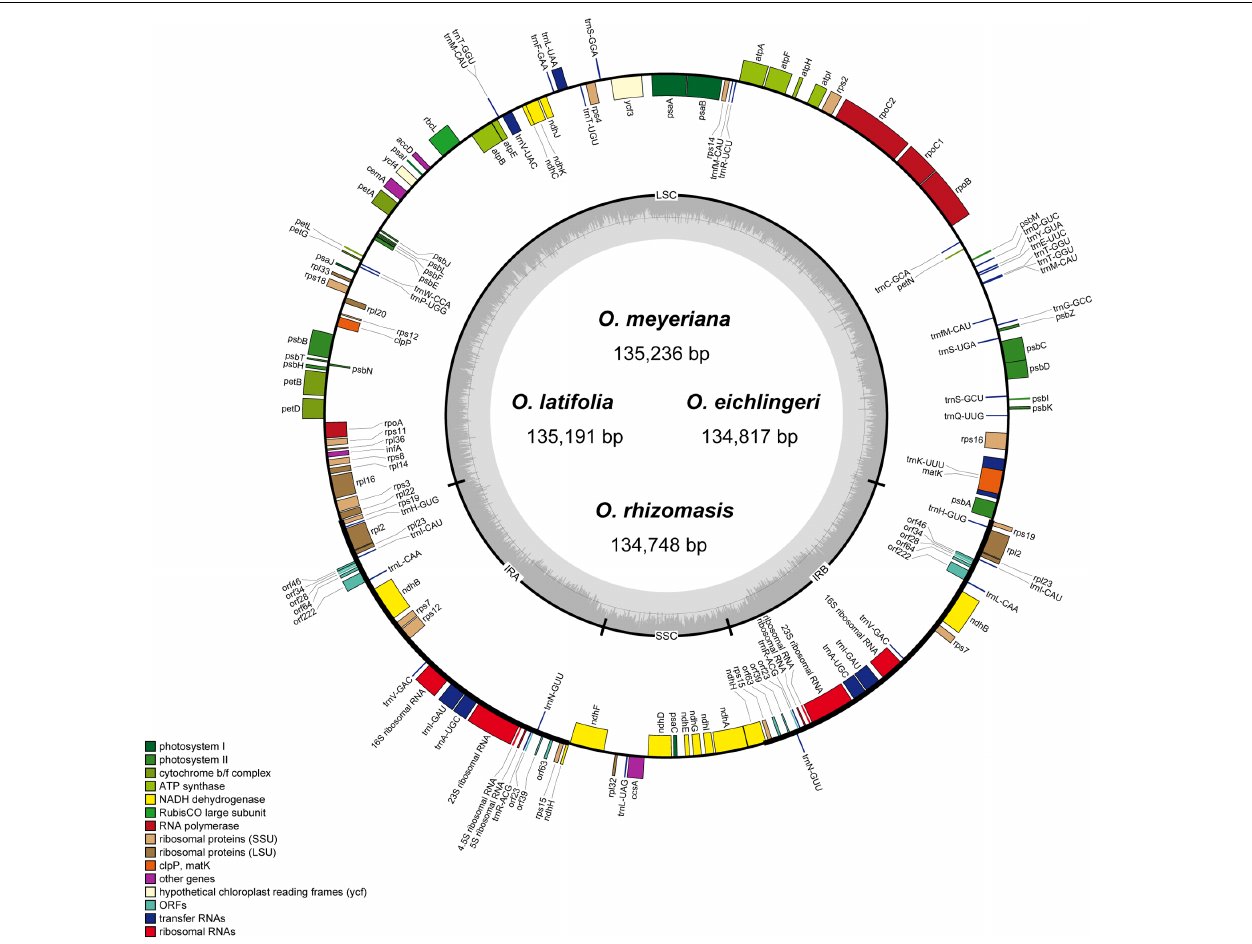
FIGURE 1 | Gene map of Oryza chloroplast genome. Genes on the inside are transcribed in the clockwise direction while genes on the outside are transcribed in the counterclockwise direction. Genes in different functional groups are shown in different colors. The thick lines indicate the extent of the inverted repeats (IRa and